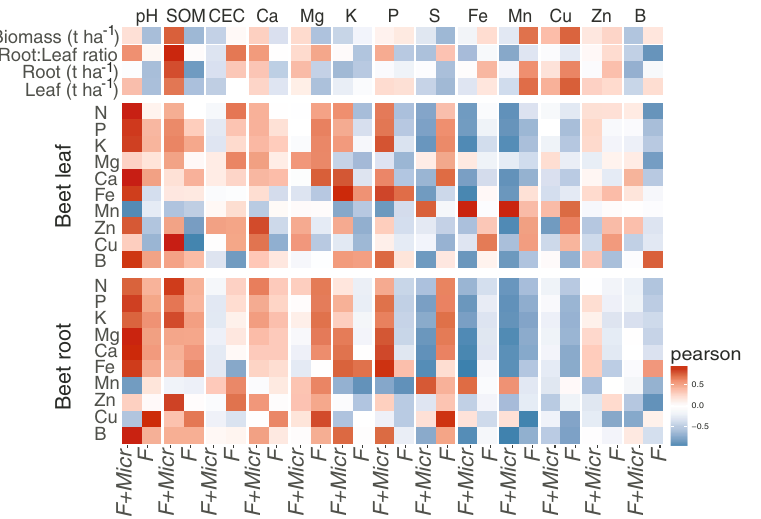
Figure 5: Correlation between elemental concentrations in the topsoil and beet leaf or root for no biochar treatments ( 2016 and 2017 beet crops ) . A similar analysis for subsoil can be found in the Supplementary Data Figure